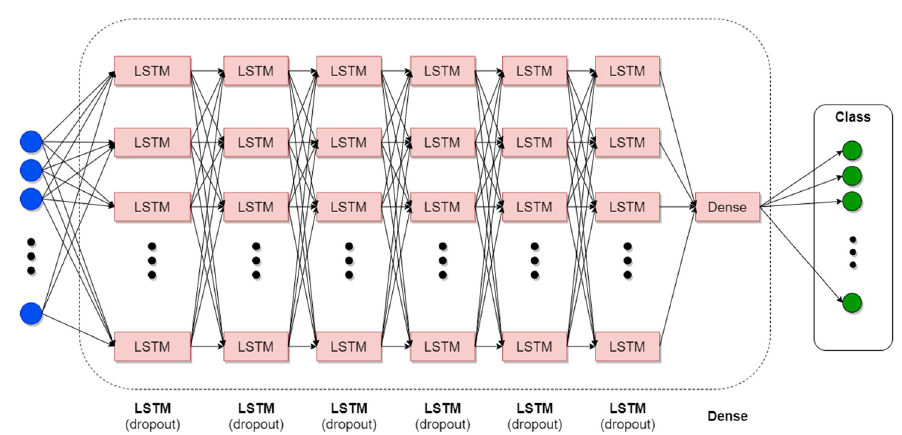
Figure 3. LSTM for time series classification model architecture.